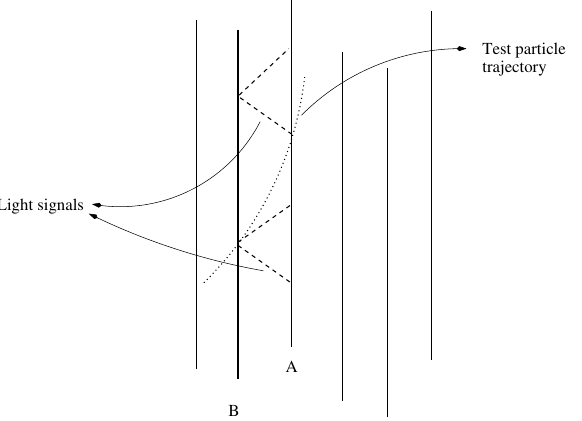
Figure 1. A congruence of nearby worldlines of fundamental observers and a test particle crossing them. The observers ( A ) and ( B ) exchange radar signals to define spatial distances and the 3-velocity of a test particle in terms of the synchronized proper